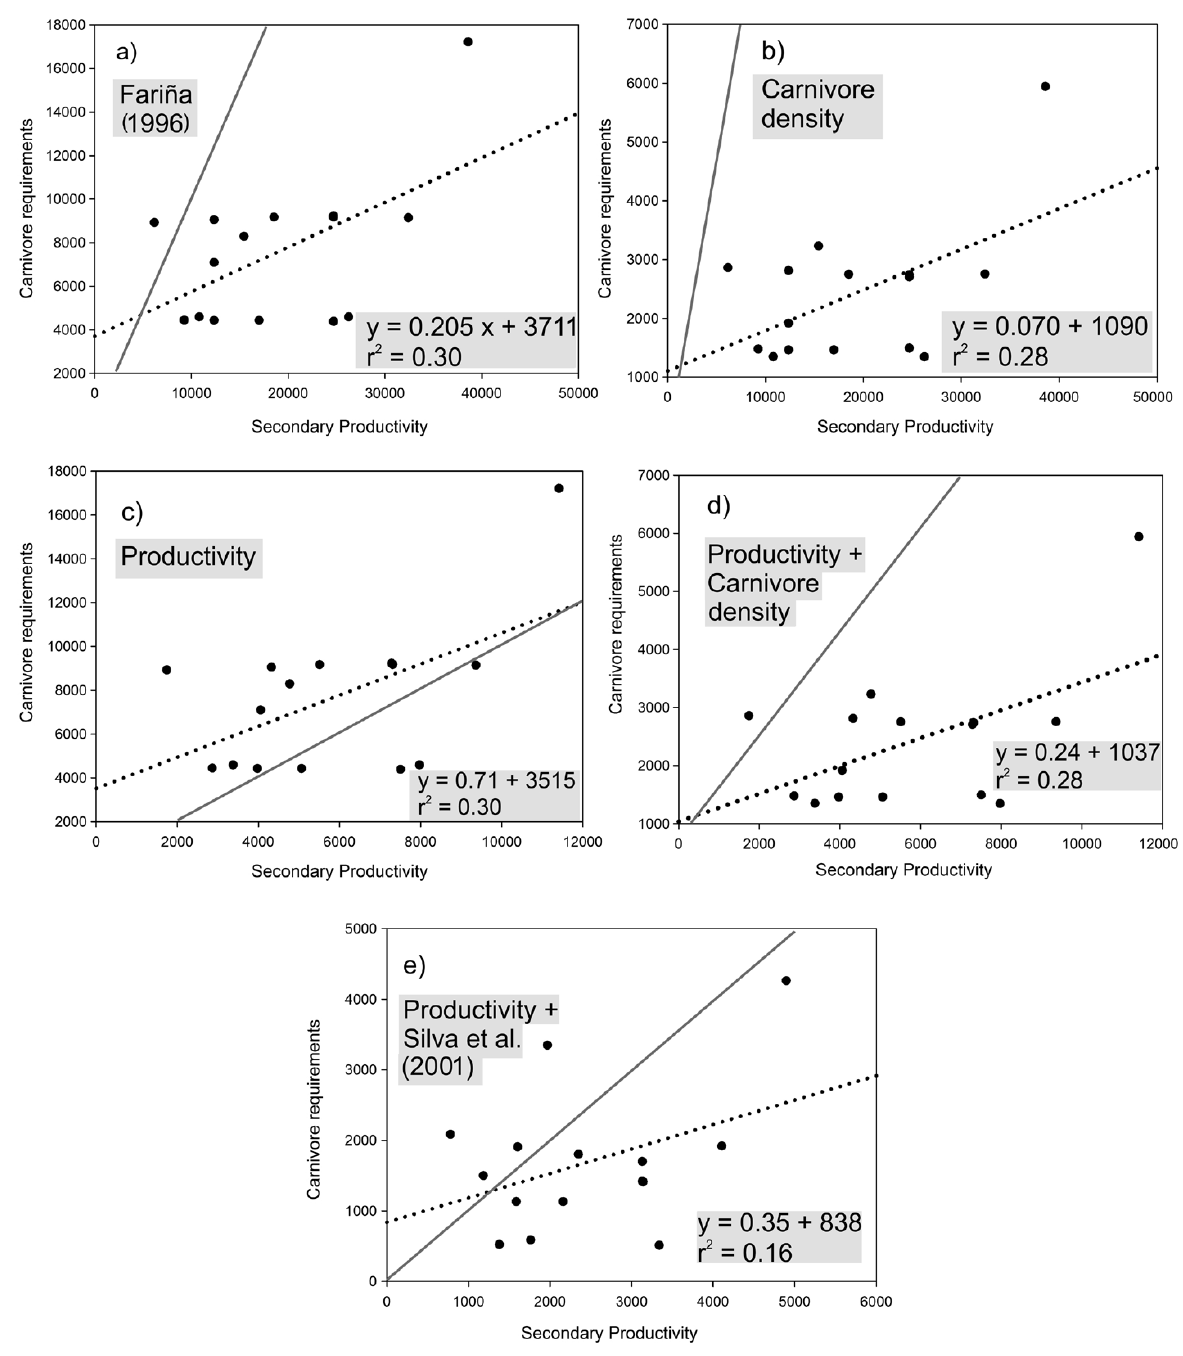
Figure 1 - Linear regressions for the five models applied to the fifteen South American Faunas. All variables are given in J m -2 year -1 . Dotted line represents the regression and solid line the expected ratio (slope =